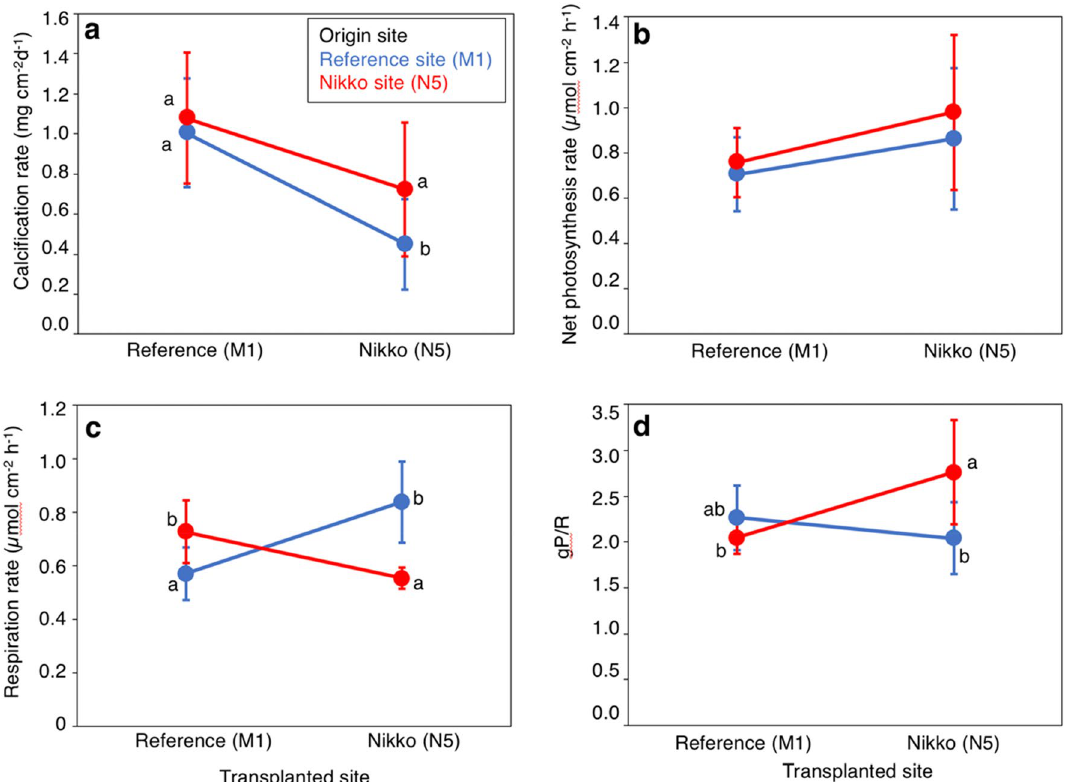
Figure 5. Metabolism of the coral Porites cylindrica reciprocally transplanted between the reference site (M1) and Nikko Bay site (N5). (a ) Calcification rate (n = 12), ( b ) net photosynthesis rate (Pn, n = 9), ( c ) respiration rate (R, n = 9), and ( d ) gross photosynthesis ratio to respiration (Pg : R, n = 9) of P. cylindrica originated from the reference site M1 (blue) and Nikko Bay site N5 (red), and reciprocally transplanted for 18 days to either sites. Bars with different lower letters show significant differences among them (Tukey–Kramer HSD, p < 0.05).